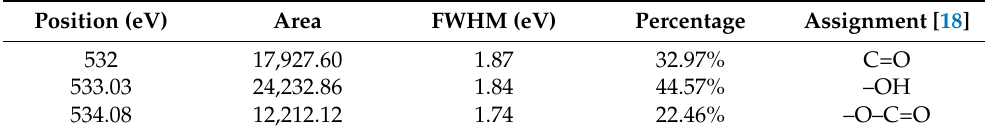
Table 4. Peakfitting results of O 1s spectrum.